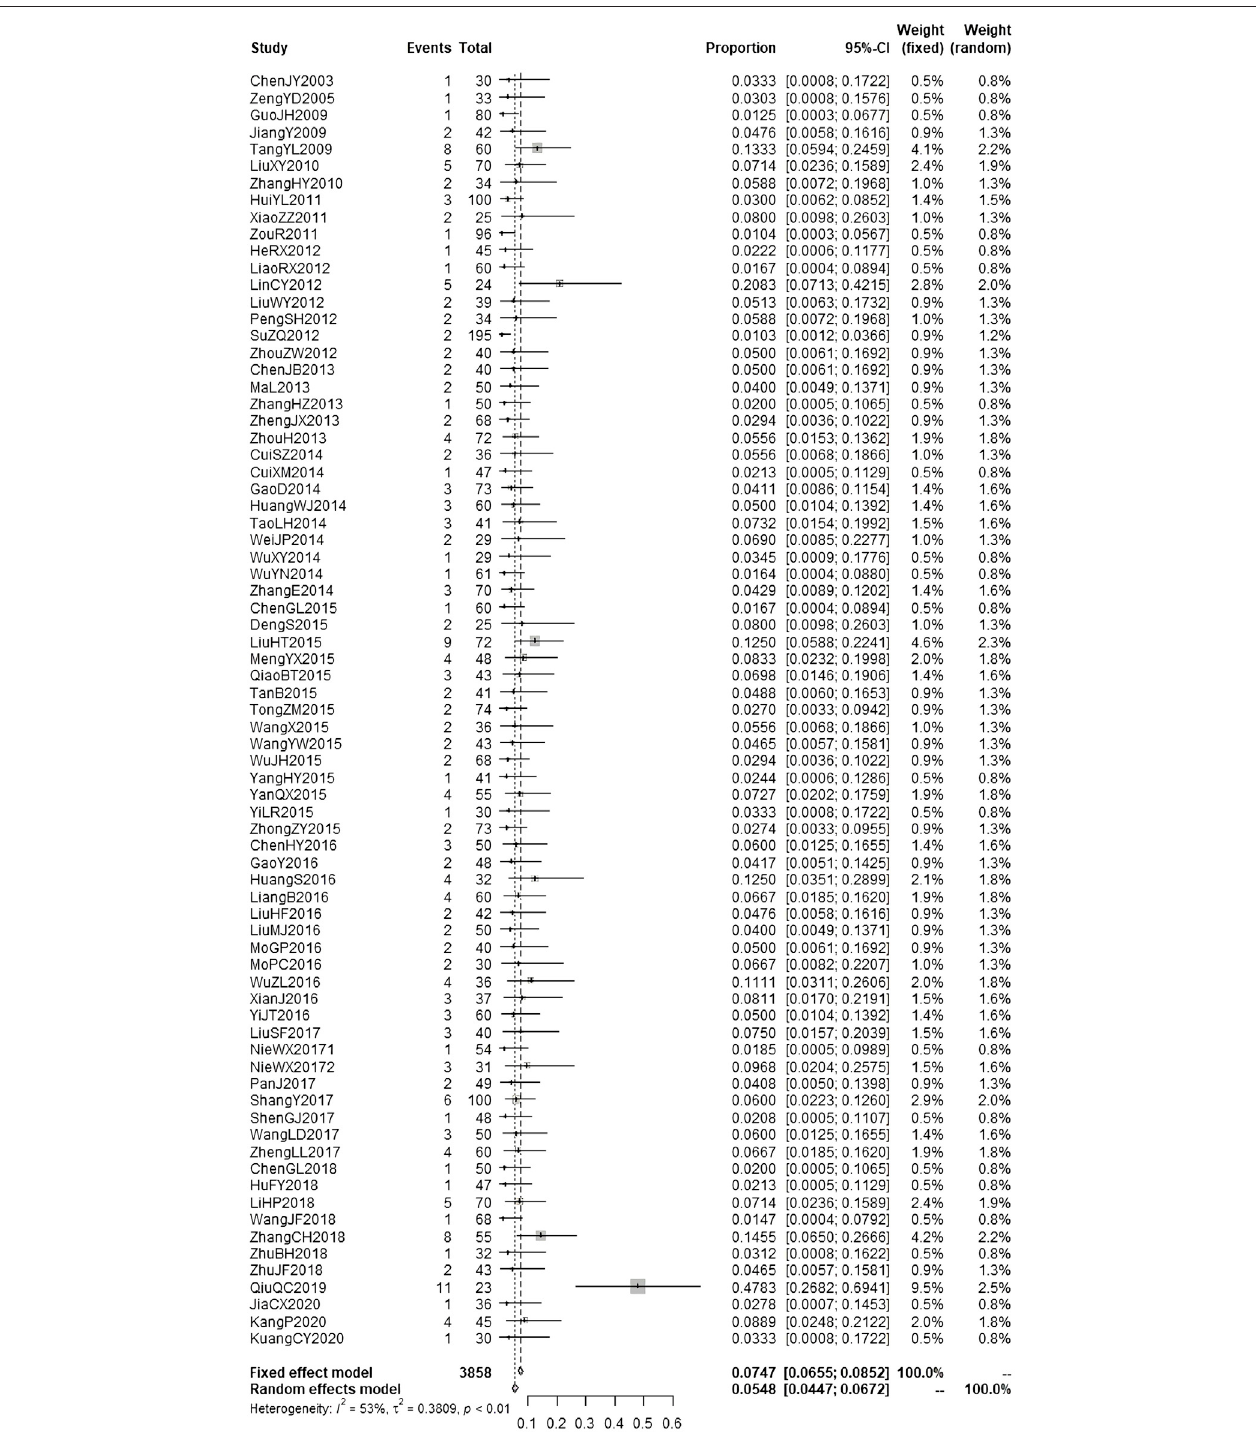
FIGURE 3 | Meta-analysis on ADR incidence of